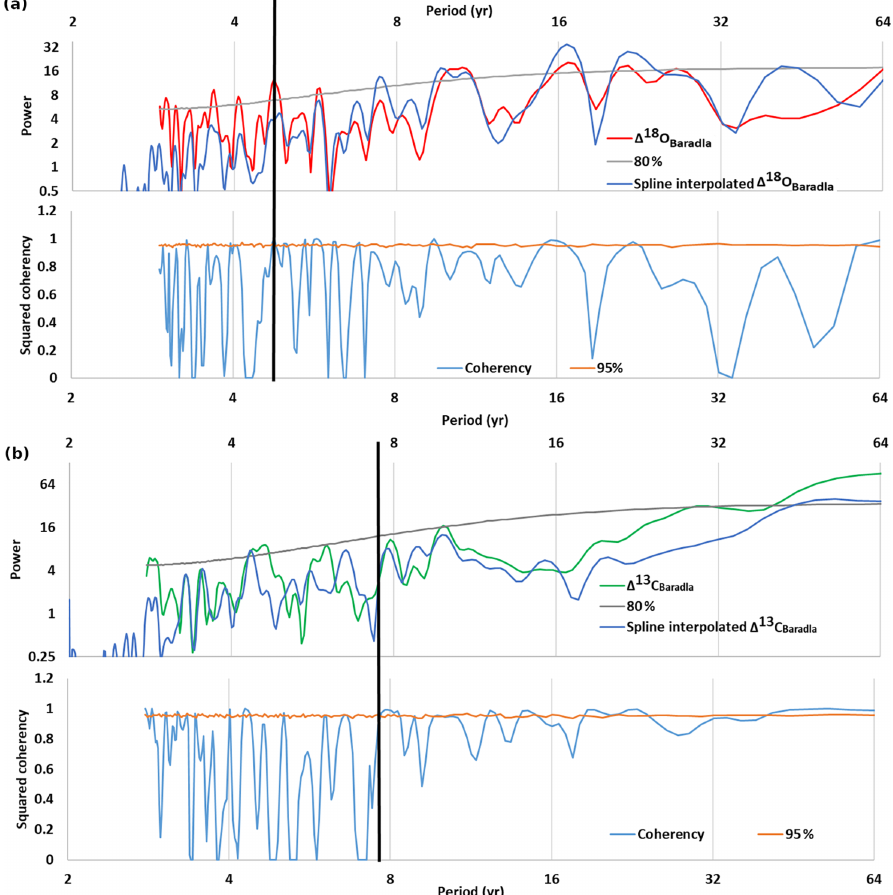
Figure 3. rLSPs (upper panels) and coherency spectra (lower panels) of the original, and the spline-interpolated (a) (cid:49) 18 O Baradla and (b) (cid:49) 13 C Baradla records of the Baradla speleothem. The bias-corrected 80% chi-squared limit of a fitted AR(1) process for the rLSPs is shown in grey. The coherency spectra were produced with a 95% Monte Carlo false-alarm levels (lower panels). The vertical black line indicates the determined cut-off